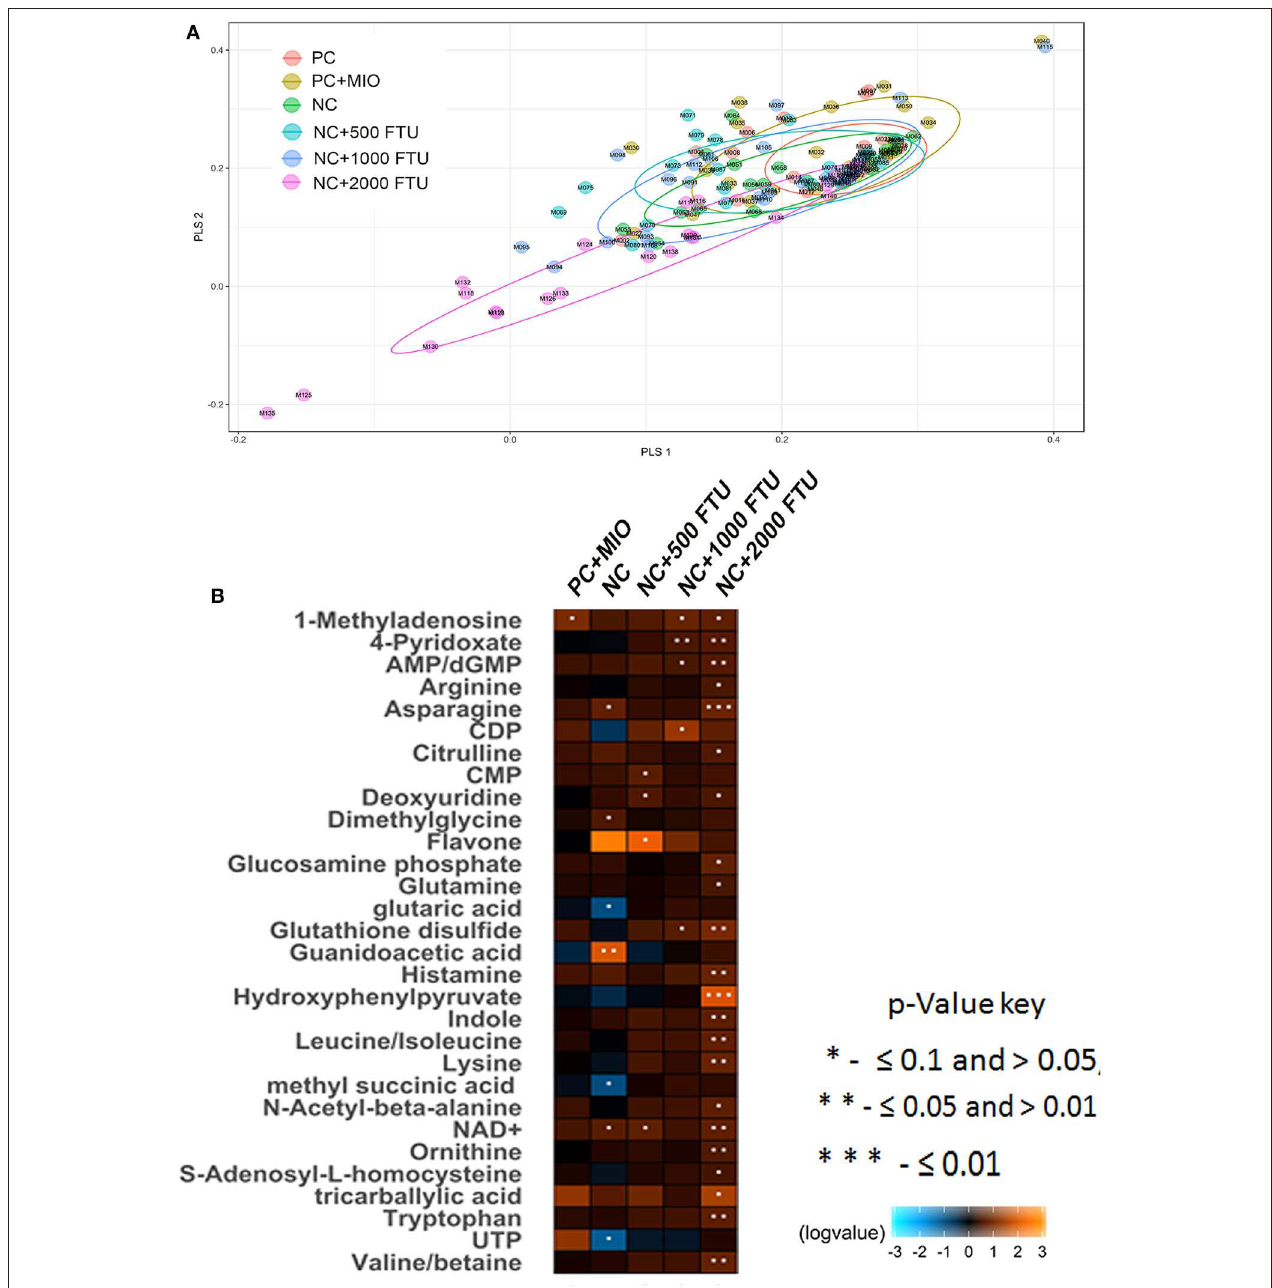
FIGURE 4 | Partial Least Squares Discriminate Analysis (PLS-DA) scores plots and heat maps of relative levels of most significant metabolites modulated by high dose quantum blue-enriched diets. (A) PLS-DA was constructed using the statistical package DiscriMiner in R version 3.6.1 and displayed different clusters when comparing metabolite profiles between all diets, (B) heat maps was build using log2 ratio and VIP score and comparing each diet to the PC